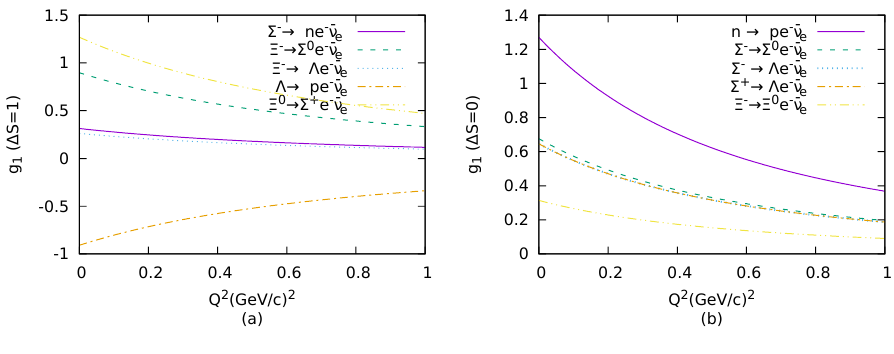
Figure 1. Variation of g 1 ( Q 2 ) with Q 2 for ∆ S = 1 and ∆ S = 0 decays.